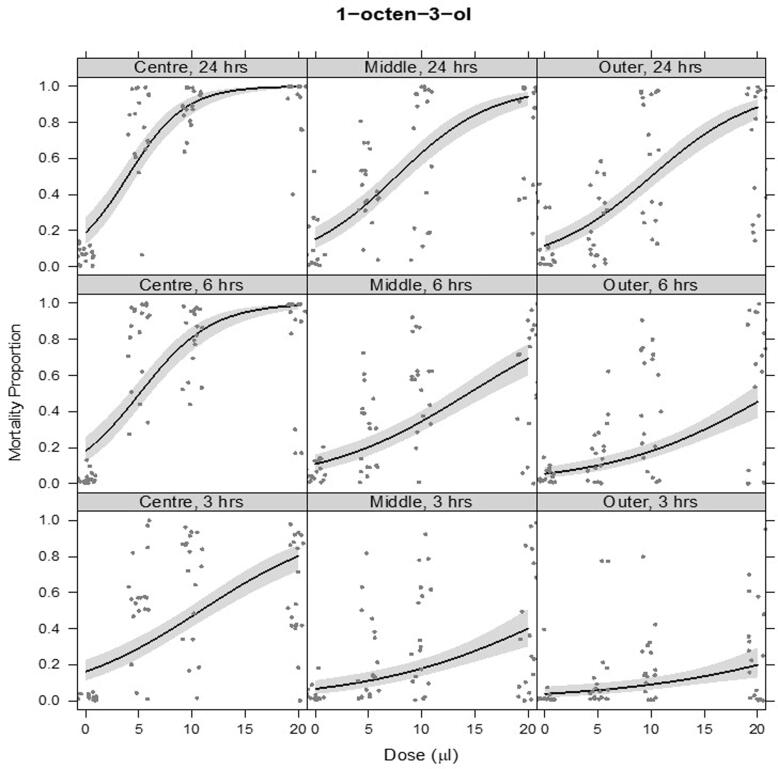
– 1-octen-3-ol. Proportional mortality of PPNs following VOC treatment over a range of dose concentrations (x-axis) and after varying times post treatment (panels by row: 3 hrs, 6 hrs, 24 hrs). This was assessed at varying distances from the centre of a circular arena (panels by column: Centre, Middle, Outer). Fitted lines are from a quasibinomial model of alive and dead nematodes. Shaded ribbons show 95% confidence envelopes. A small amount of horizontal ‘jitter’ was applied to visually separate overlapping data points.ge.